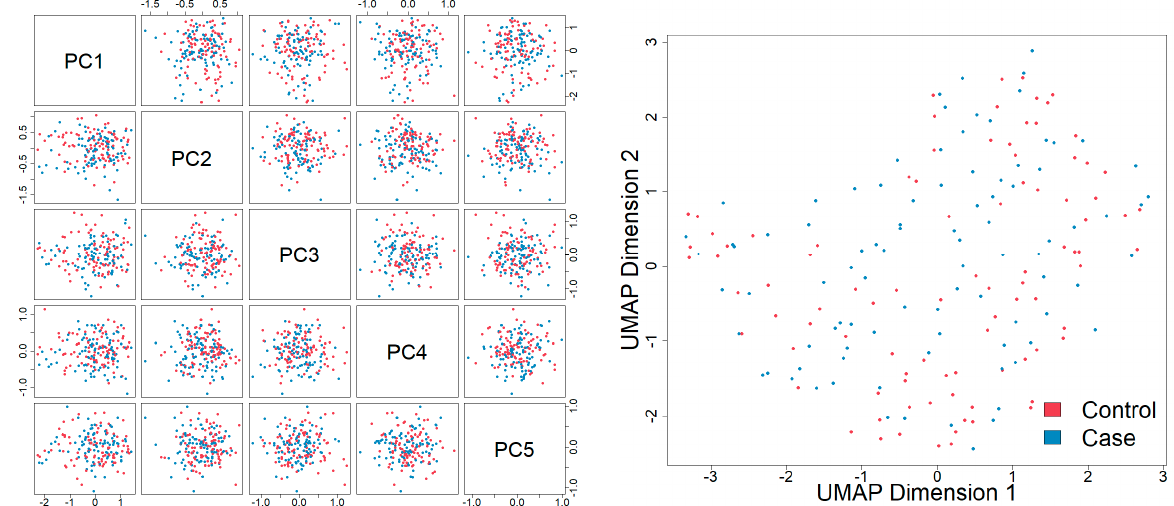
Figure 2. ( Left ) Pairwise plots of the first 5 principal components from PCA on only the 11 folate metabolites and all subjects, with plotting symbols for subjects colored by case/control status. ( Right ) Results of UMAP on only the 11 folate metabolites and all subjects plotted and colored by case/control status. Blue = cases (n = 92) and pink = controls (n = 92).